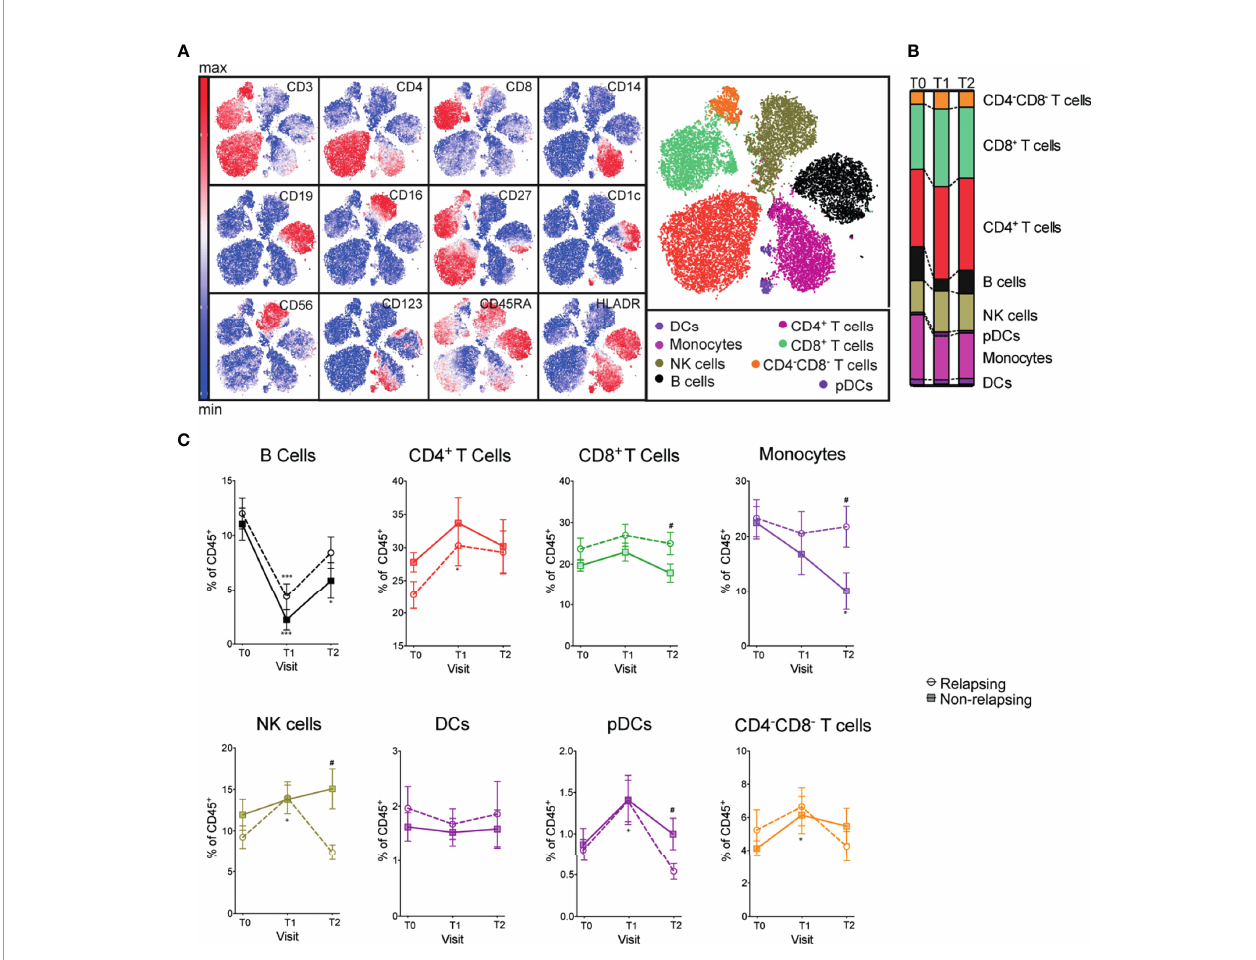
FIGURE 2 | Frequencies of major immune compartments in INS patients receiving OFA or RTX therapy. (A) viSNE analysis of peripheral blood mononuclear cells (PBMC) from a representative patient including 3 time points (during immunosuppressive treatment, after immunosuppressive treatment withdrawal and at the time of relapse) colored by the relative expression of CyTOF markers to designate major immune clusters [populations de fi ned in (B) ]. (C) Percentages of major immune compartments once demultiplexed and based on the summation of Phenograph clusters before (T0) and serially after (T1 and T2) anti-CD20 therapy. Comparisons between relapsing and non-relapsing at the same timepoint # p < 0.05. Comparisons between different timepoints *p < 0.05, ***p < 0.001. Two-way ANOVA corrected for multiple comparisons. Data points depict mean ±